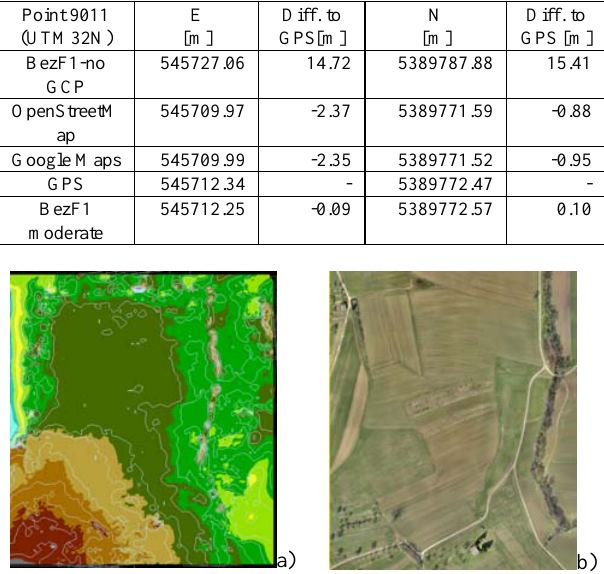
Table 6: Comparison of point 9011 coordinates.